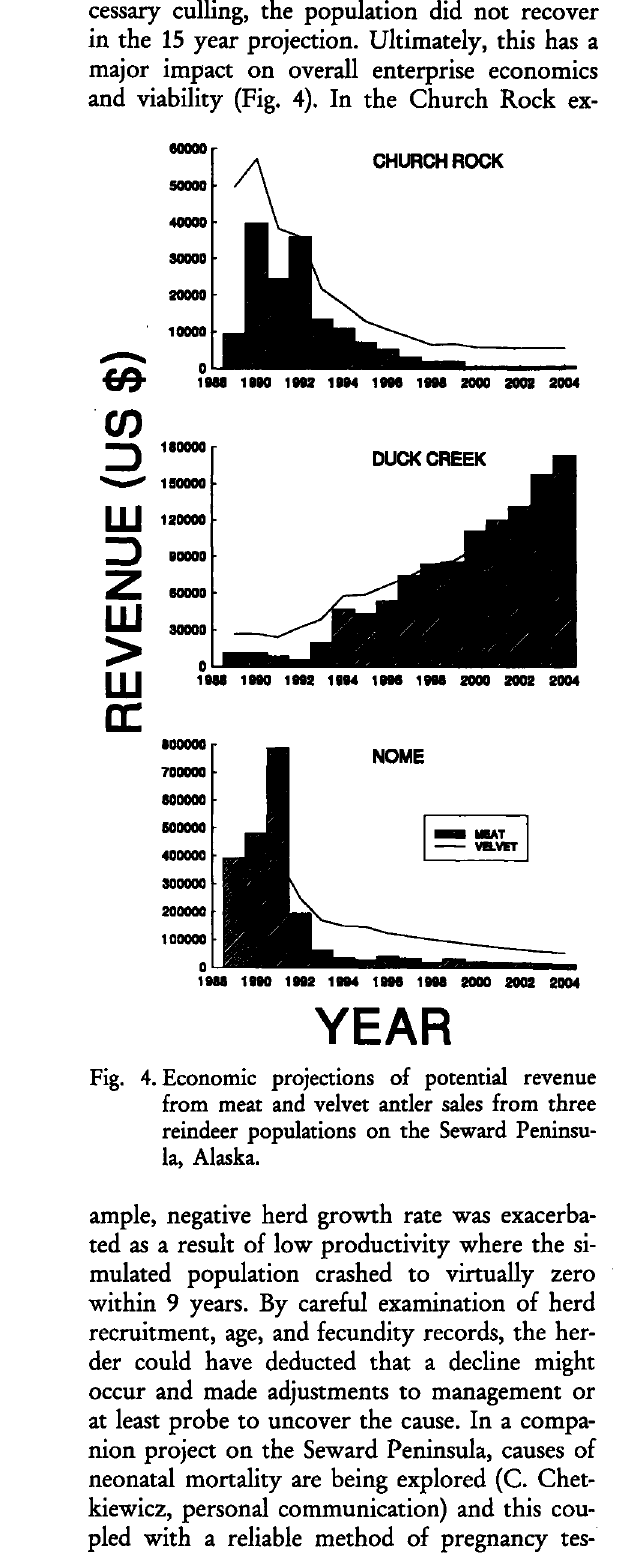
Fig. 4. Economic projections of potential revenue from meat and velvet antler sales from three reindeer populations on the Seward Peninsu la,